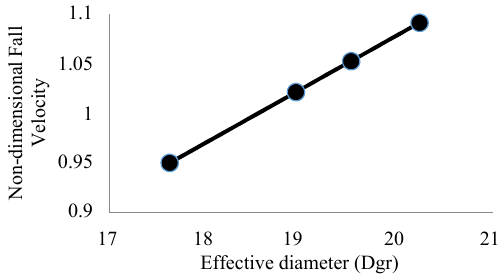
Fig. 11. Correlation between non-dimensional fall velocity and effective diameter in numerical